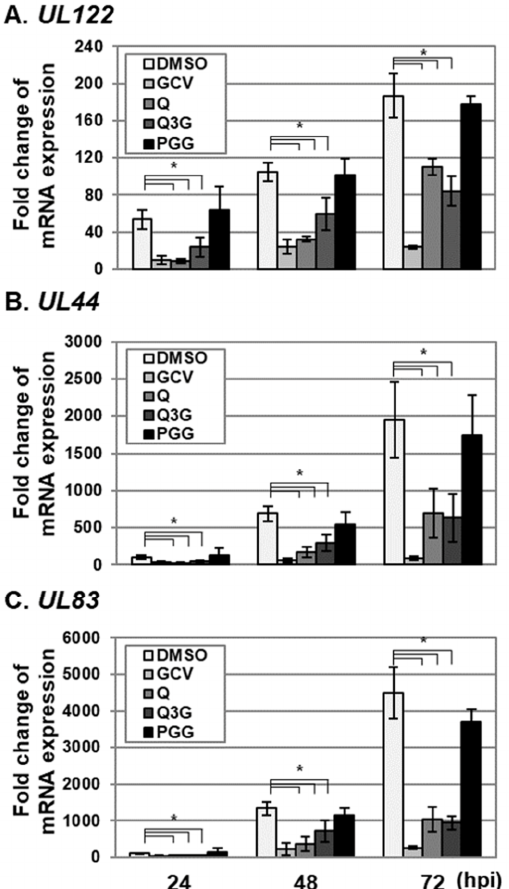
Figure 5. E ff ects of quercetin and isoquercitrin on HCMV lytic-gene expression. HFF cells were infected with HCMV–Towne at an MOI of 0.1, followed by treatment with DMSO, quercetin (Q), and isoquercitrin (Q3G) or 1,2,3,4,6-penta-O-galloyl-ß-D-glucose (PGG) at a concentration of 20 µg/mL. As a control, HCMV–Towne-infected HFF cells were treated with GCV (2.3 µg/mL). At 24, 48, and 72 h after infection, total RNA was isolated and reverse-transcribed into cDNA. Relative mRNA levels of ( A ) UL122 (IE), ( B ) UL44 (E), and ( C ) UL83 (L) were measured via qRT–PCR. For quantification of the relative abundance of viral mRNA between samples, the value of virus-infected cells treated with DMSO was set at 100. Significant di ff erences between samples were determined using Student’s t test (significant at * p < 0.05). Data shown here represent three independent sets of